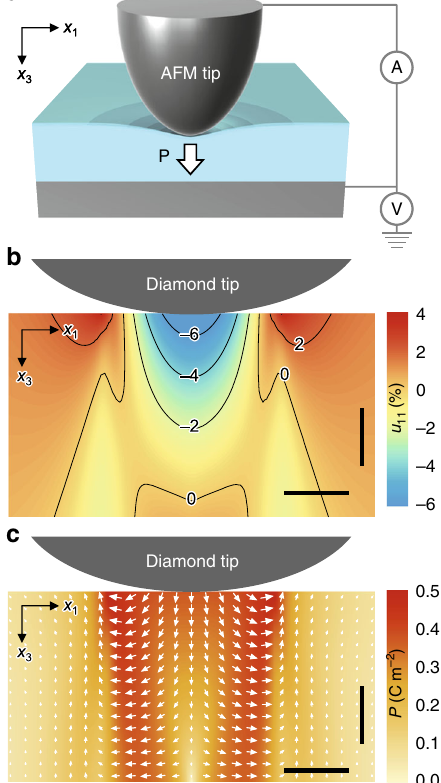
Fig. 2 Mechanically induced large polarization in ultrathin dielectrics. a Schematic diagram of the experimental setup, illustrating the fl exoelectric polarization (white arrow) generated by the atomic force microscope (AFM) tip pressing the surface of ultrathin dielectrics. While generating large strain gradients, we simultaneously measure the tunneling currents across the fl exoelectrically polarized STO. b , c Phase- fi eld simulations for the transverse strain u 11 ( b ) and corresponding polarization distribution ( c ) in ultrathin STO under a representative tip loading force of 15 μ N over a circular area ~13nm in radius. Vertical and horizontal scale bars represent 1 nm and 10 nm, respectively. Source data are provided as a Source data fi